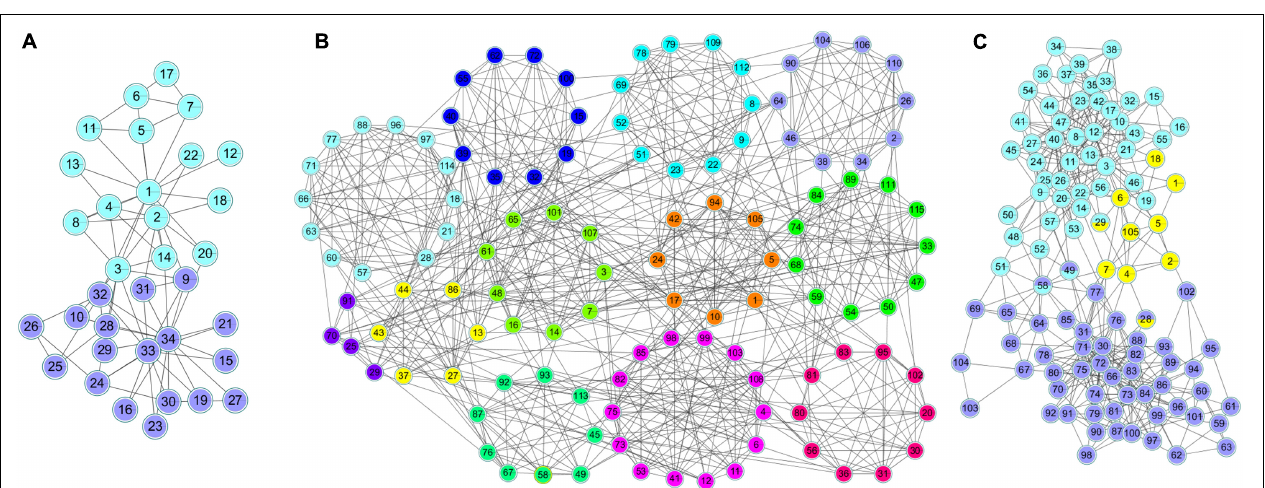
FIGURE 6 | The division results of the NLC algorithm in three standard networks: (A) Karate, (B) Football, and (C) Polbooks network.